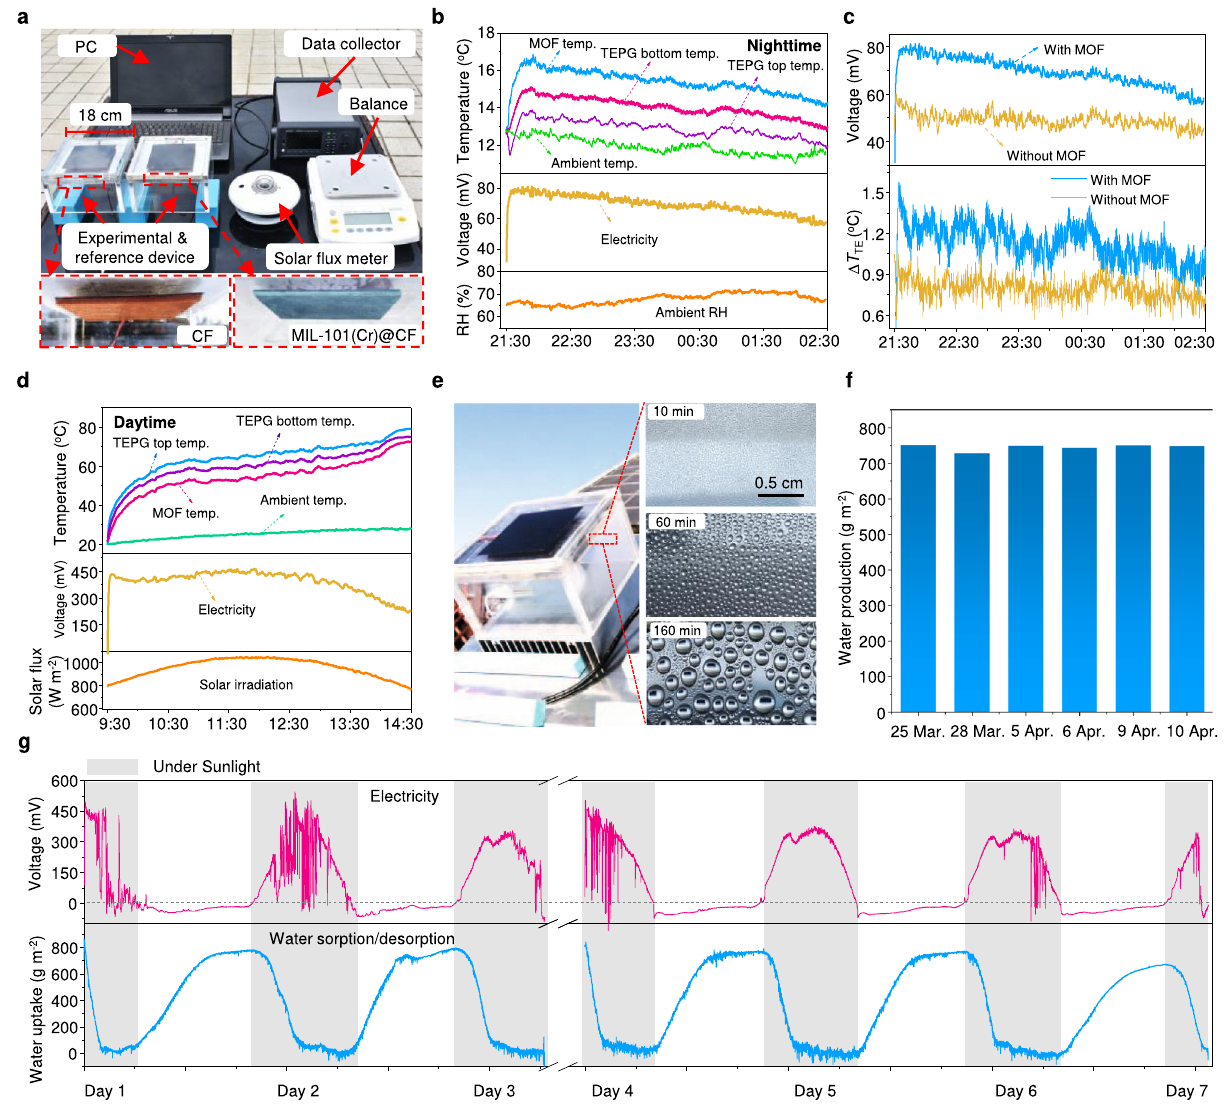
Fig. 5 | Outdoor demonstration of the hybrid SAWH-TEPG device for water production and 24-hour power generation. a Photograph of the hybrid SAWH- TEPG device with MIL-101(Cr)@CF (right) and the referenced device without MIL- 101(Cr) (left) for outdoor experiments. b Real-time evolutions of air RH (bottom), open-circuit voltage (middle), ambient temperature, MOF temperature, and TEPG temperature(top) during nighttime. c Real-time evolutions of open-circuit voltage andtemperaturedifference Δ T TE forpowergenerationinthehybriddeviceandthe